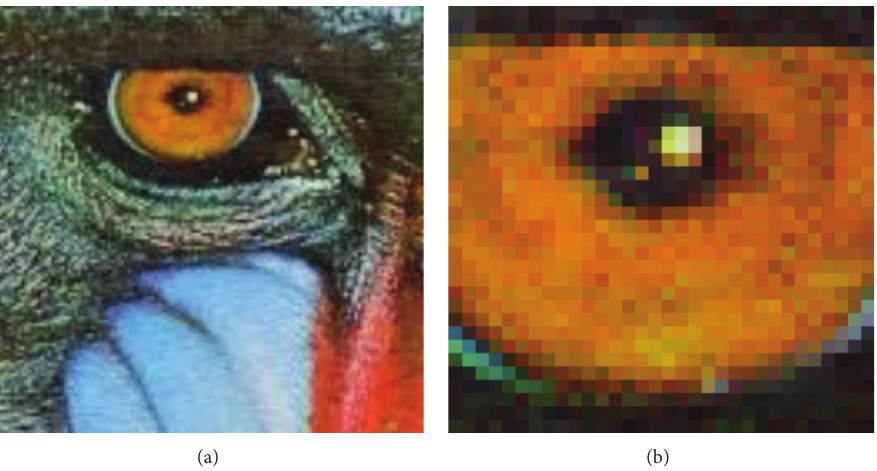
Figure 9: Original baboon image (a) zoomed in to 400% (b).